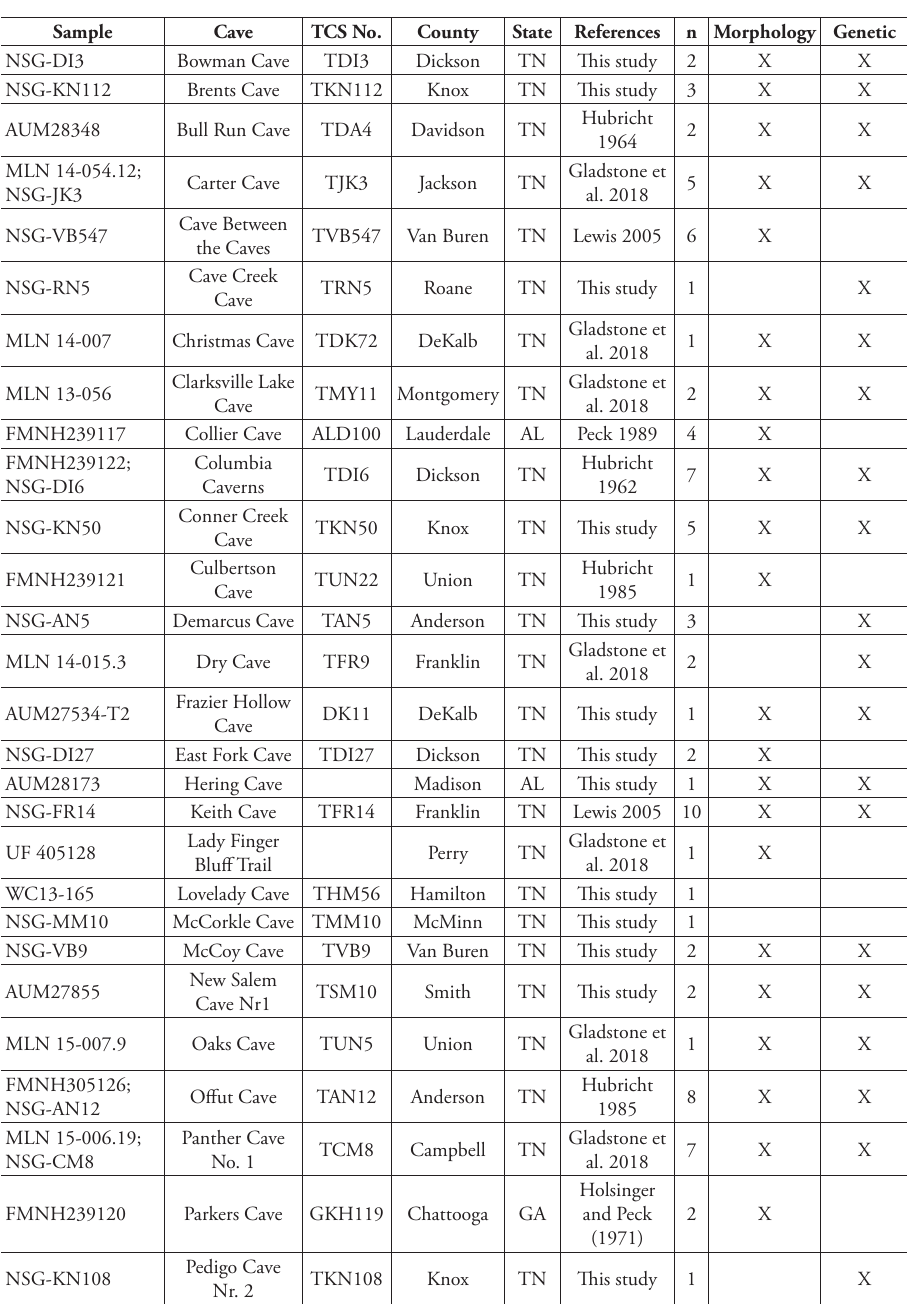
Table 1. Helicodiscus barri populations incorporated in this study, including 17 new populations. Cave names, Tennessee Cave Survey (TCS) cave number, county and state are provided, as well as information regarding which populations were considered in morphometric and genetic